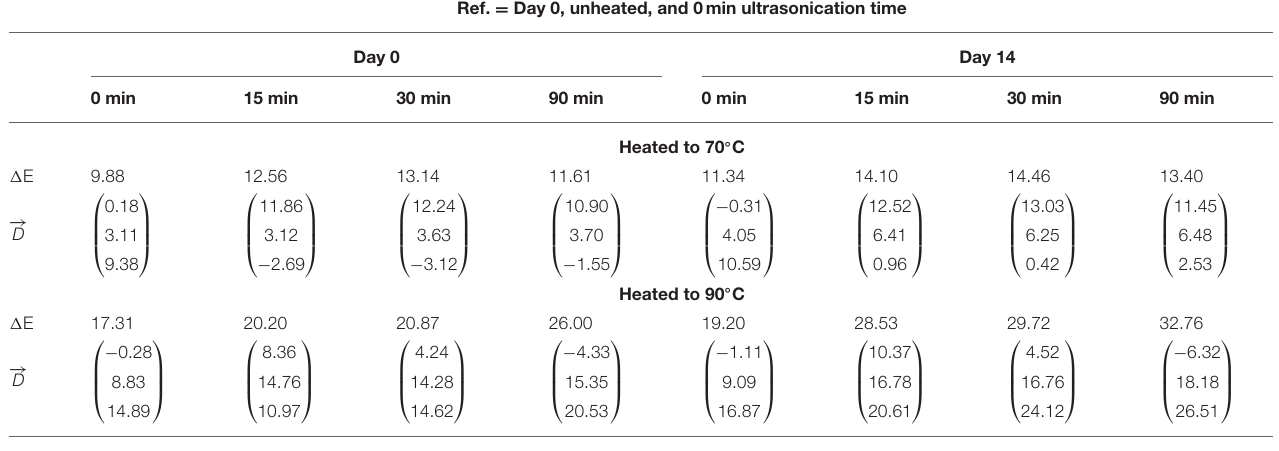
TABLE 1 | Color difference ( 1 E) and difference vectors of PC: λ C (1:4) complexes at a pH of